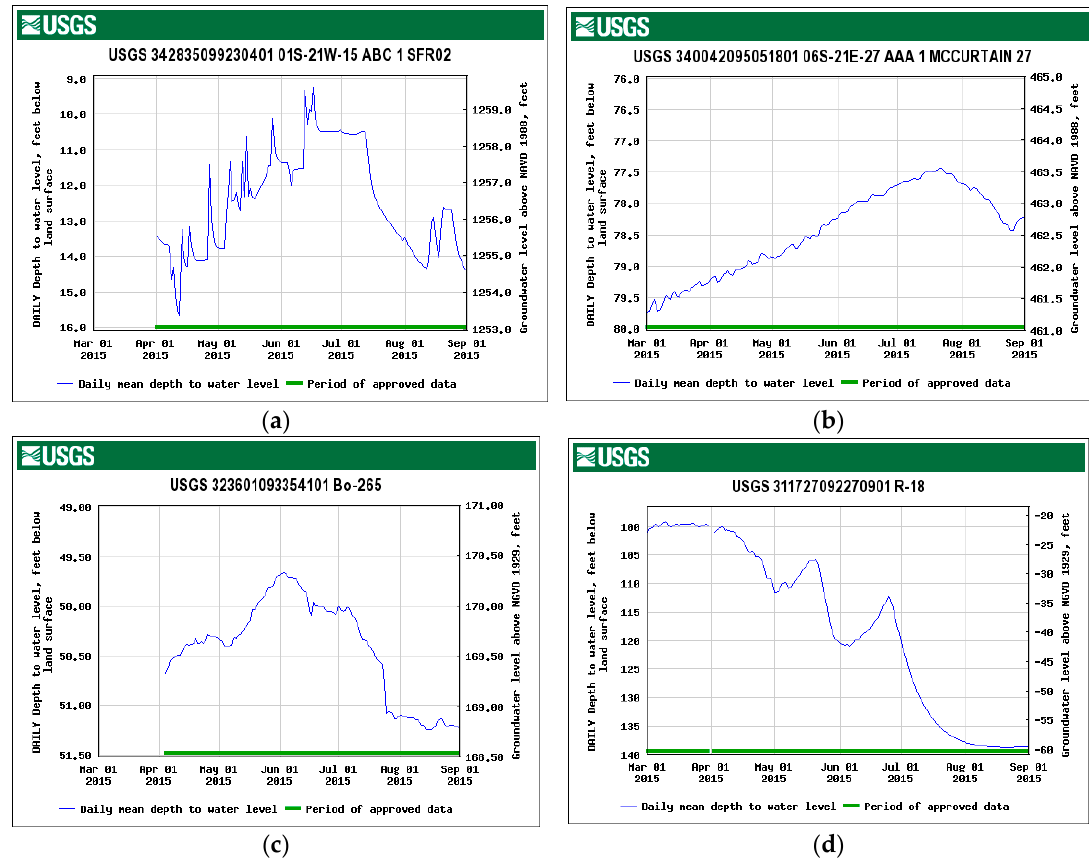
Figure 6. The artesian well levels in: ( a ) Jackson County, Oklahoma, USA—riverhead of the Red River; ( b ) McCurtain County, Oklahoma, USA—middle course of the Red River; ( c ) Shreveport, Louisiana, USA—upper flooded area; ( d ) Alexandria, Louisiana, USA—lower flooded area.